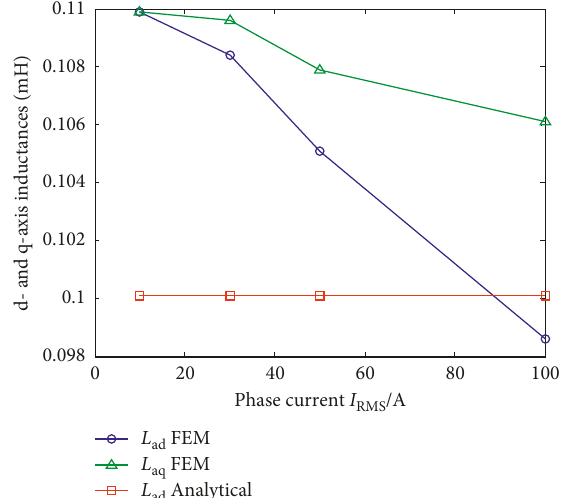
Figure 7: Curves of L ad and L aq vs the